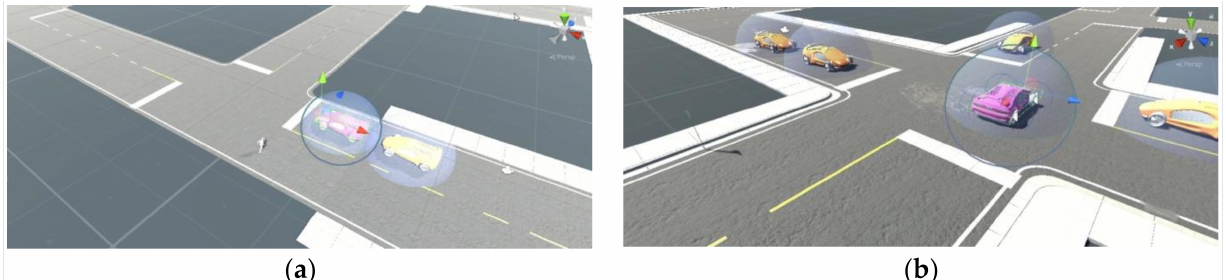
Figure 3. ( a ) Pedestrian crossing scenario, ( b ) four-way stop sign scenario.